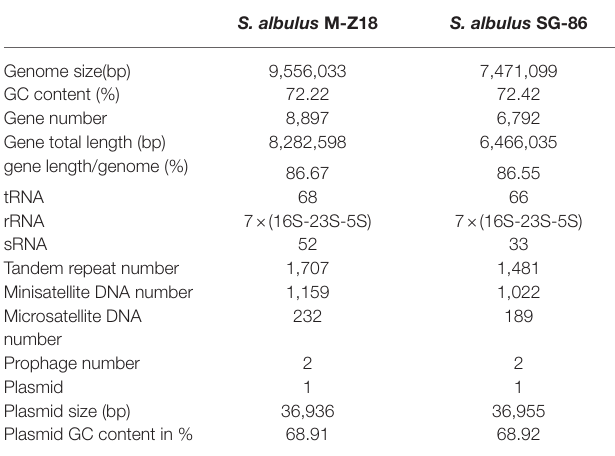
TABLE 1 | General features of genomes of Streptomyces albulus M-Z18 and Streptomyces albulus